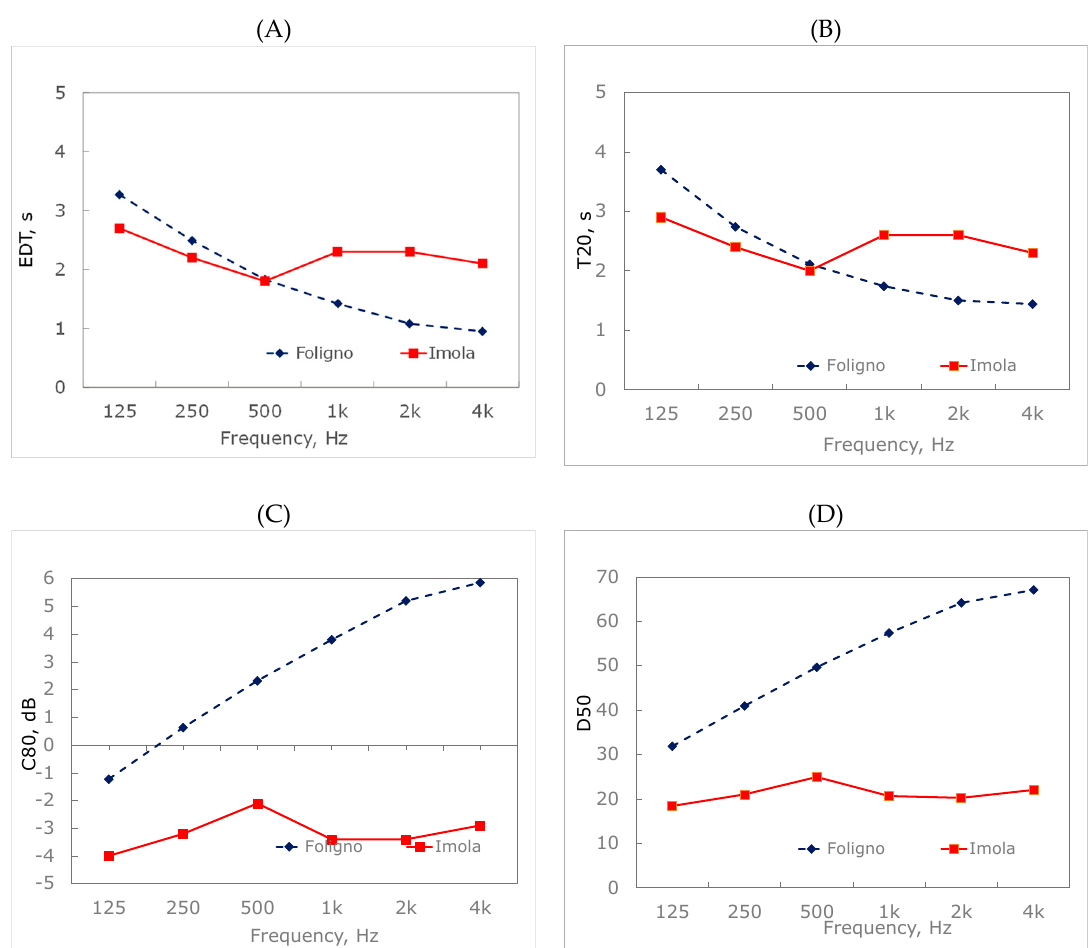
Figure 12. Simulated acoustical parameters. (A) EDT; (B) T 20 ; (C) C 80 ; (D) D 50